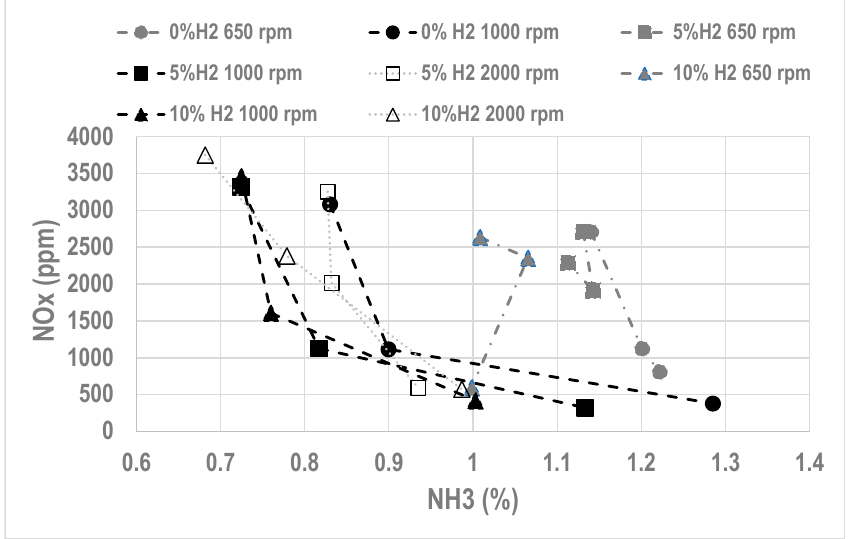
Figure 4. NOx emissions vs NH3 emissions for %H2 content (0.5 and 10), 3 engine speeds and equivalence ratio. P in = 1 bar.